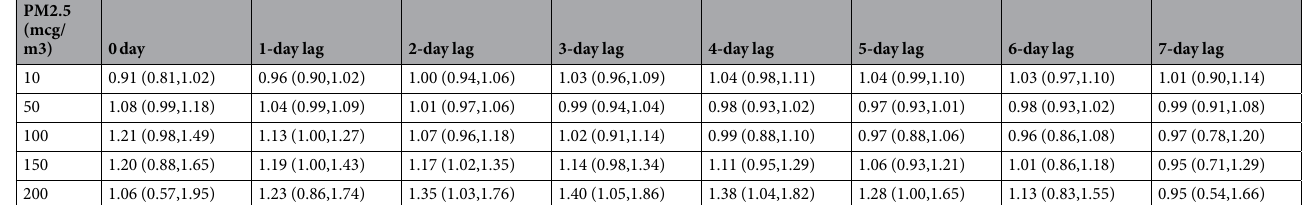
Table 3. Relative risks of ICU admission due to pneumonia at specific combinations of PM2.5 values and lag times. Note: distributed lag non-linear model was fit by incorporating PM2.5, mean temperature and week. PM2.5 value and its lag effect were modelled by polynomials function with 2 degrees of freedom. Temperature and its lag effect were modelled with nature cubic spline functions. A PM2.5 value of 30 mcg/m3 was employed as reference, and relative risks of other concentrations were compared to this